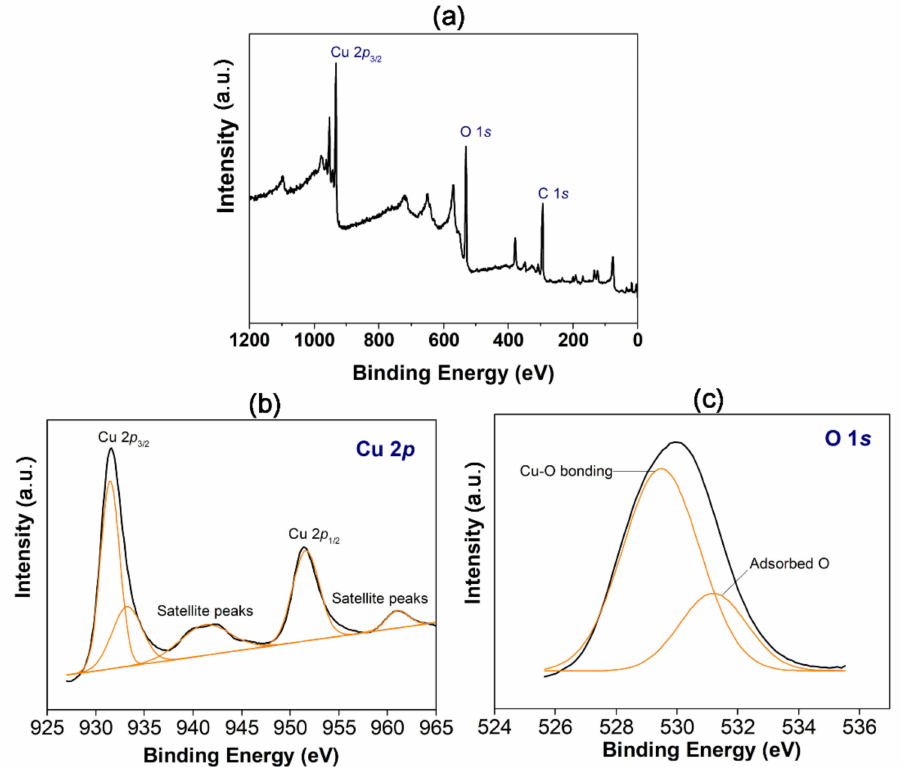
Figure 4. ( a ) XPS survey spectra of M. calabura derived CuO nanoparticles, ( b ) high-resolution Cu 2 p peaks, and ( c ) high-resolution O 1 s peaks.